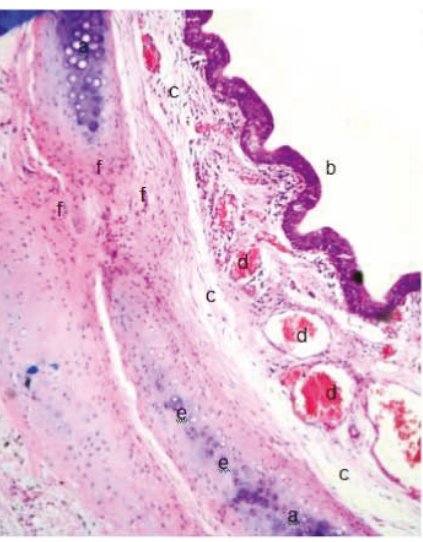
Figure 14: Tissue regeneration in the SIS group with reepithelialization, neovascularization, and newly formed cartilage, H&E (40x): (a) mature cartilaginous tissue, (b) pseudostrati fi ed ciliated epithelium, (c) connective tissue, (d) blood vessels, (e) immature cartilaginous tissue (newly formed cartilage), and (f) fi